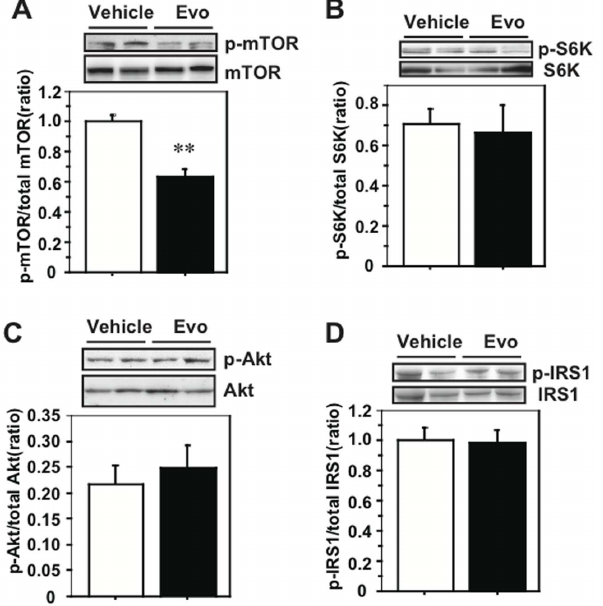
Figure 4. Effect of evodiamine on the mTOR-S6K signaling in the liver of mice treated with evodiamine. Western blot analysis for mTOR (A), S6K (B), Akt (C) and IRS1 (D) were done with tissue lysates (30–50 m g protein) of liver from the KK-Ay mice treated with evodiamine for 7 days. Phosphorylation levels of mTOR Ser2448, S6K Thr389, Akt Ser473 and IRS1 Ser636/639 were normalized to the total level of each protein. Data are expressed as mean 6 SEM ( n =5). ** p , 0.01 vs. vehicle group.